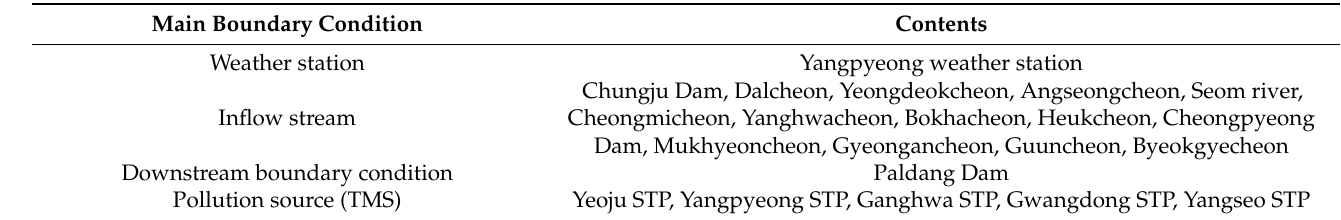
Table 2. Main boundary condition of EFDC-NIER model in Han